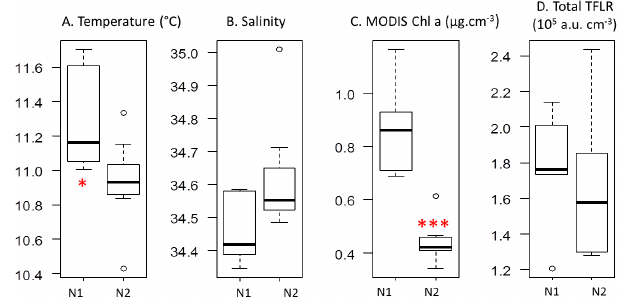
Figure 11. Box plots within each PHYSAT anomaly (N1, N2) of (a) temperature ( ◦ C), (b) salinity, (c) chlorophyll a (as estimated from MODIS level 3 binned) and (d) total TFLR (a.u.cm − 3 ) . Wilcoxon rank test was run for each parameter between the two anomalies. *** p <0.001; ** p <0.01; * p